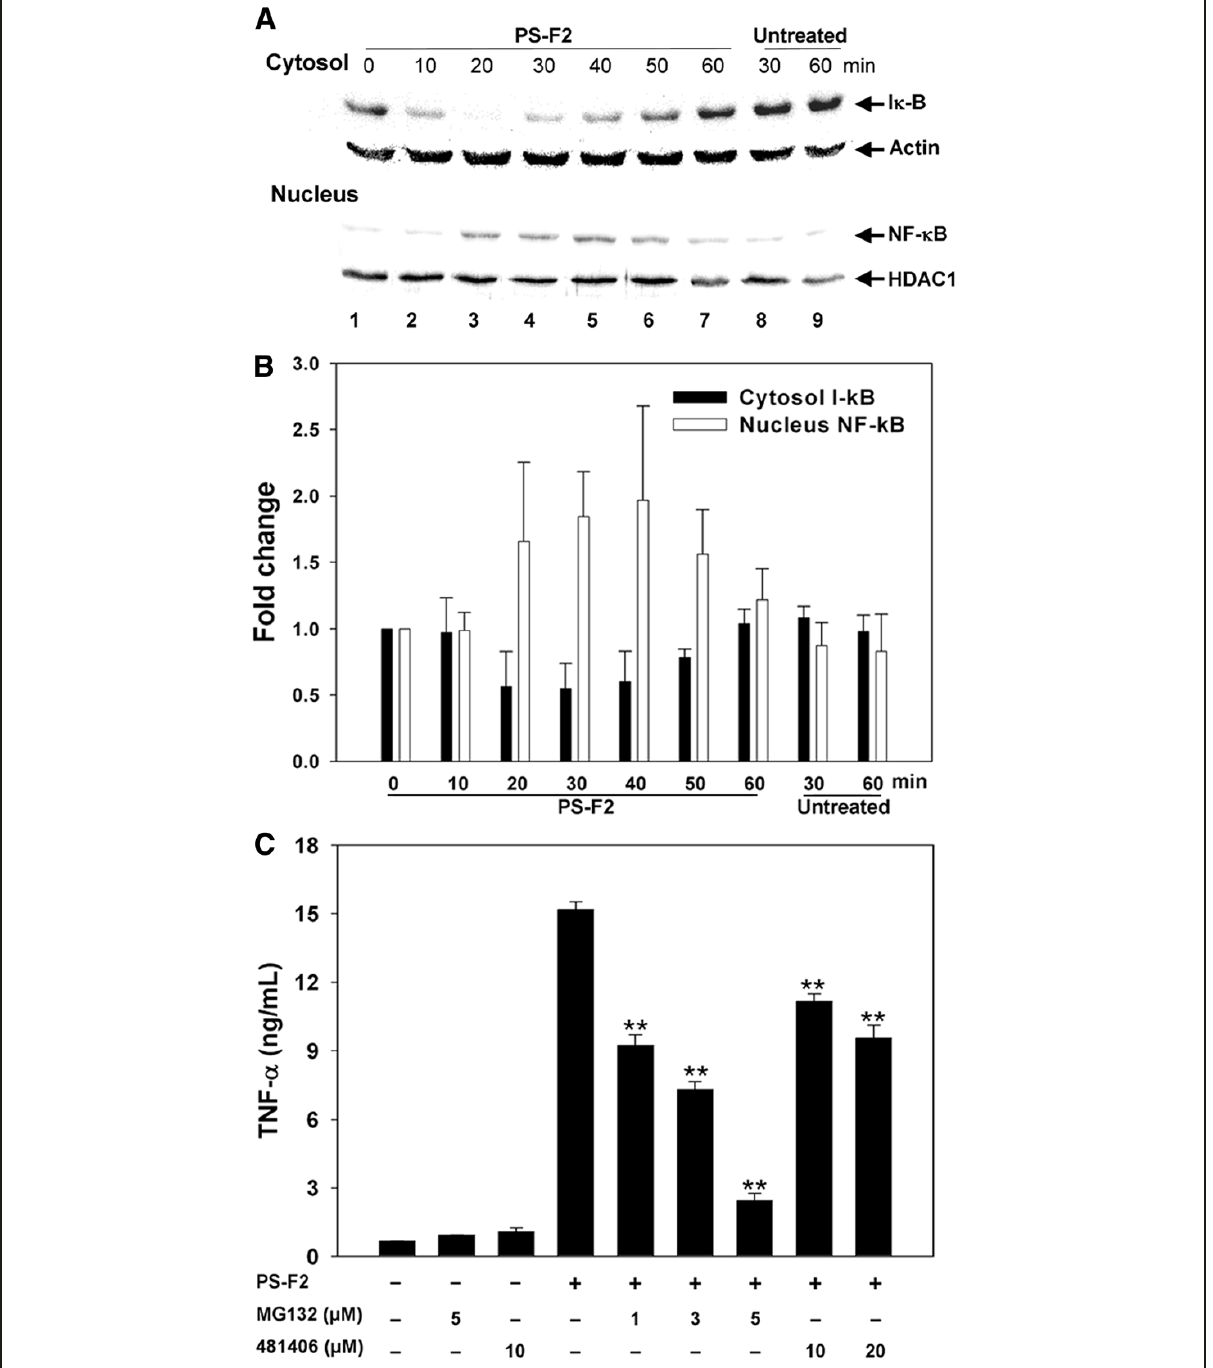
Figure 4 NF- κ B activation is required for PS-F2-stimulated TNF- α production in macrophages. ( A ) RAW264.7 cells were untreated or stimulated with PS-F2 (8 μ g/ml), and the cytosolic and nuclear fractions were prepared at indicated time points. Equal amounts of protein from the cytosolic fractions were subjected to Western blotting for I- κ B and actin, and equal amounts of protein from the nuclear fractions were subjected to Western blotting for NF- κ B and HDAC1. ( B ) Signals in panel A were quantified by densitometric analysis. I- κ B signals were normalized against actin signals, and NF- κ B signals were normalized against HDAC1 signals. Bars indicate the fold changes of I- κ B and NF- κ B amounts at indicated time points over those at 0 min ( n = 3). ( C ) RAW264.7 cells were pre-incubated with or without MG132 or 481408 (NF- κ B activation inhibitors) for 30 min and stimulated with PS-F2 (15 μ g/ml) for additional 20 h in the presence or absence of inhibitors. Cells left untreated or treated with inhibitors alone served as controls. TNF- α levels in the culture fluids were determined by ELISA ( n = 3). Data shown are representative of 3 or more experiments. ** P < 0.01 versus PS-F2 stimulation alone in ( C